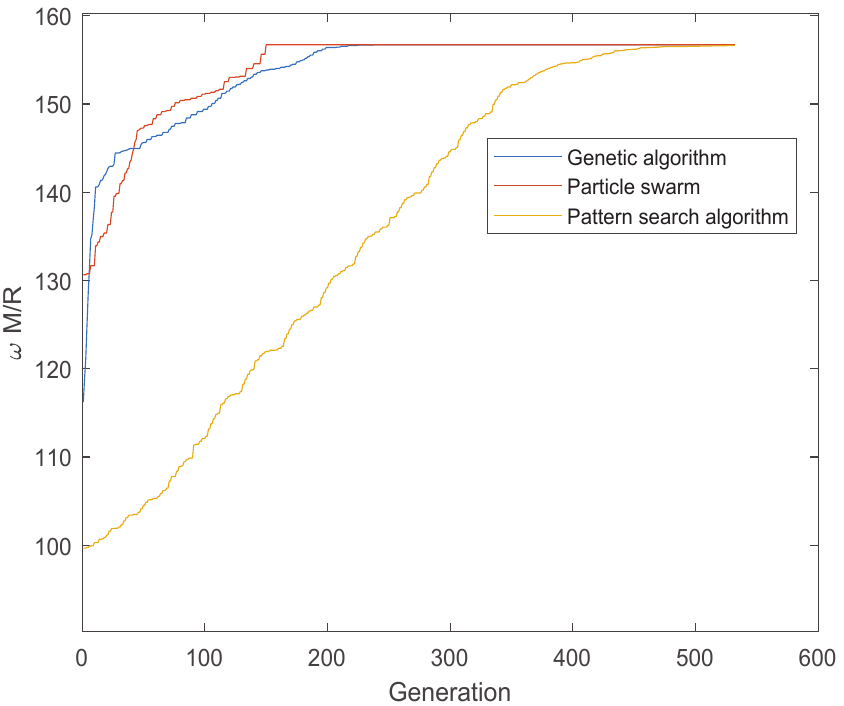
Figure 9. Convergence curve of genetic algorithm, particle swarm, and pattern search.